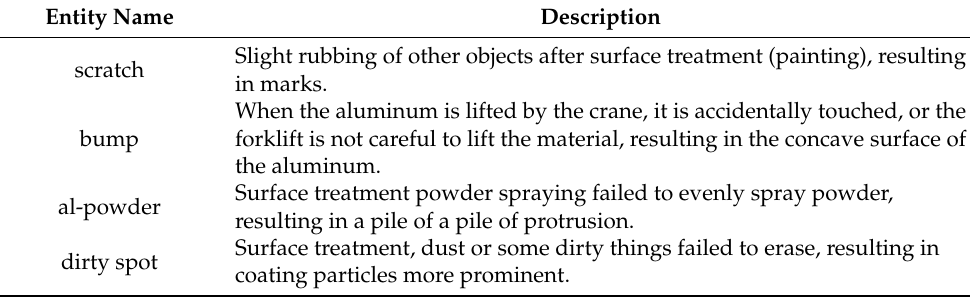
Table 7. Description of entity